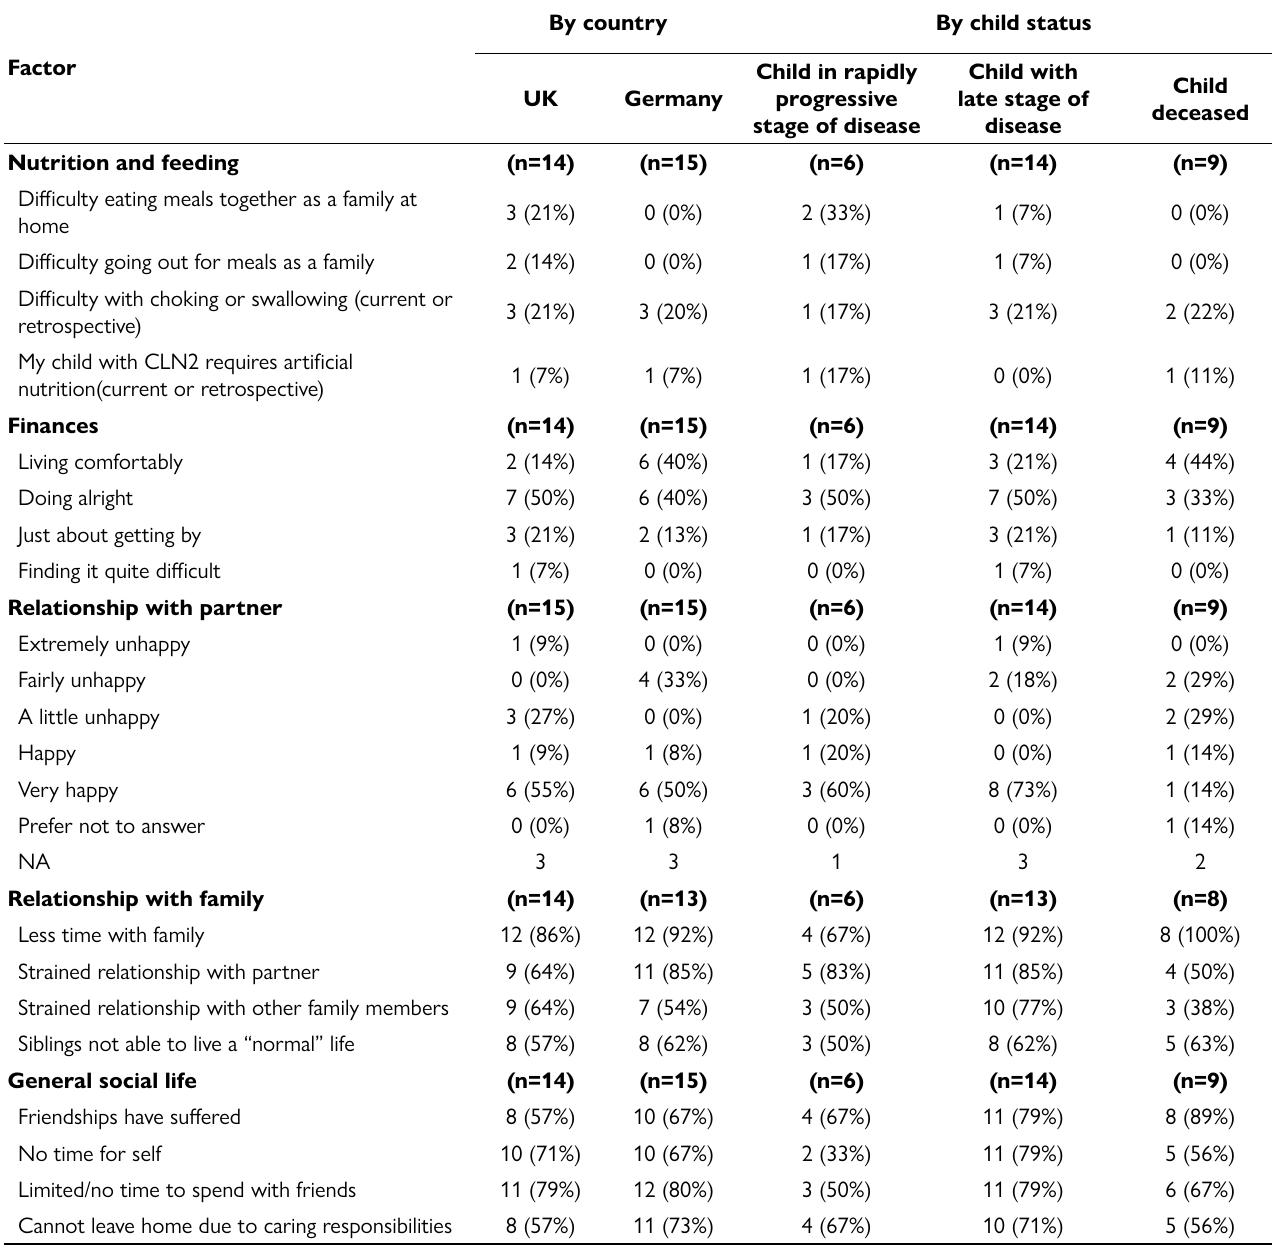
By country By child status Child in rapidly Child with Child UK Germany deceased stage of disease disease